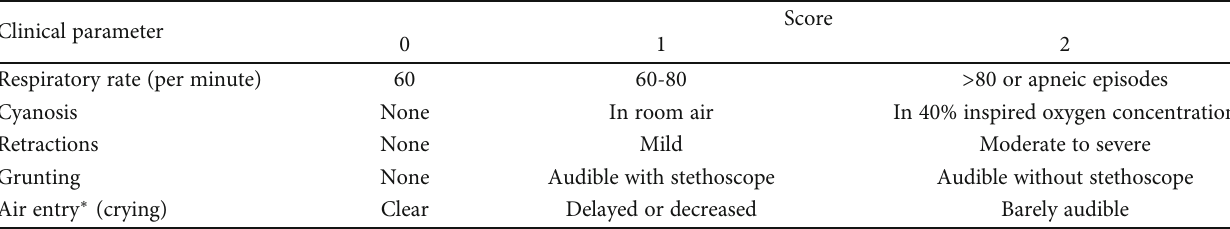
Figure 1: Illustration of a low-cost improvised bNCPAP circuit. Table 3: Downes score.